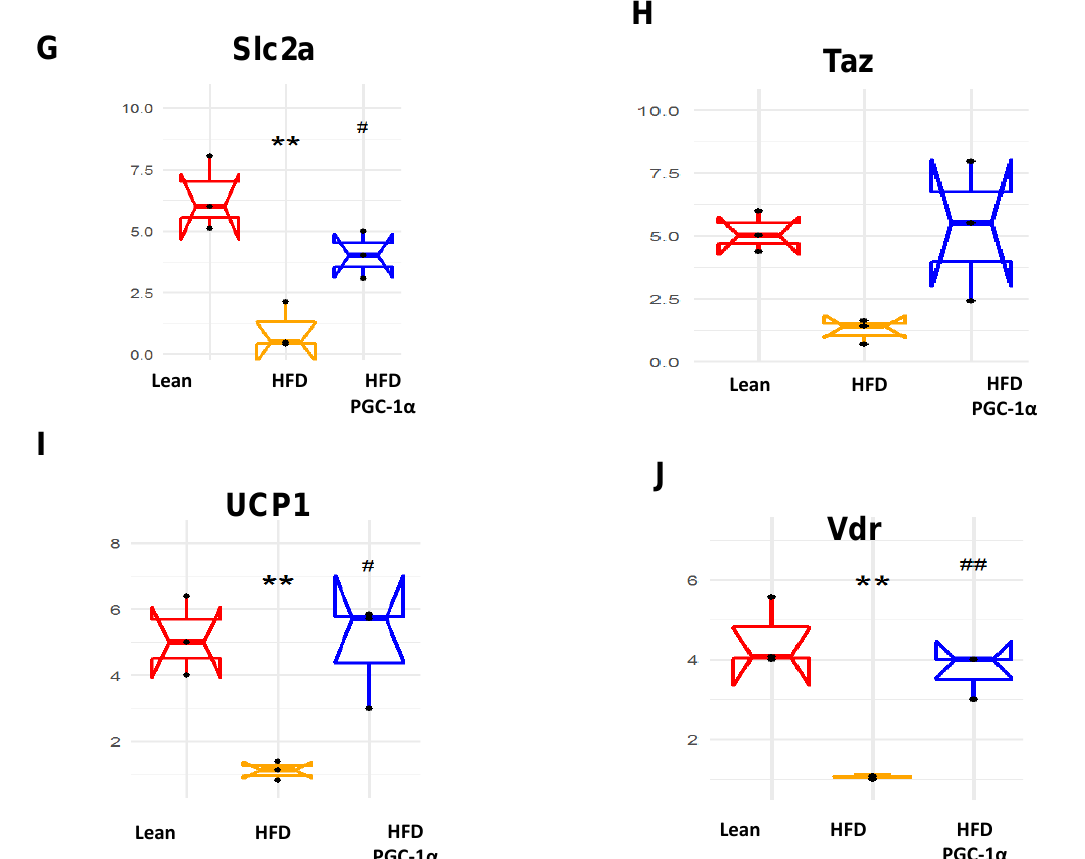
Figure 7. The mRNA expression of ( A ) adiponectin, ( B ) insulin receptor precursor (Insr), ( C ) lipopro- tein lipase (Lpl), ( D ) Prdm16, ( E ) Sonic hedgehog (Shh), ( F ) silent mating-type information regulation 2 homolog (Situin1), ( G ) solute carrier family 2 member 4 (Slc2), ( H ) Tafazzin (Taz), ( I ) Uncoupling protein 1 (UCP1), and ( J ) vitamin D receptor (Vdr) in the adipose tissue of lean, high-fat-diet (H.F.D.)- fed and Transgenic-adipo-PGC-1 α mice. Data are expressed as mean ± S.E.M. ( n = 5); * p < 0.05, ** p < 0.005 vs. lean; # p < 0.05, ## p < 0.005 vs.